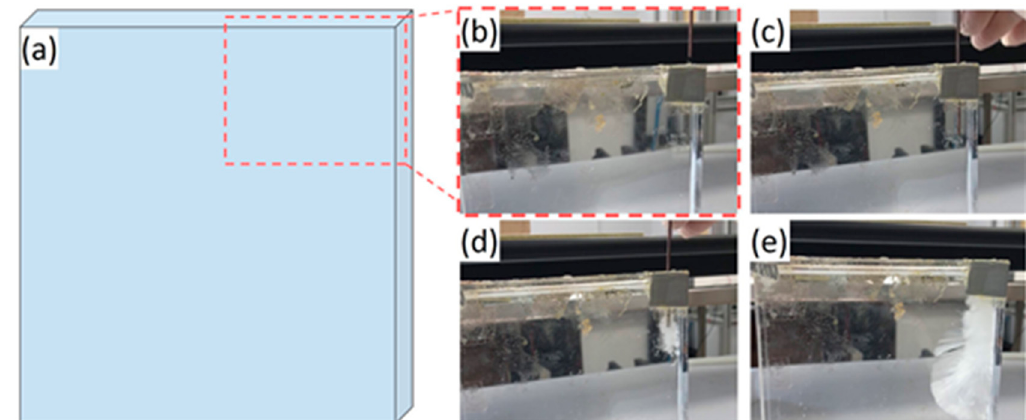
Figure 4. Seeding of sodium acetate trihydrate (SAT) with a welding rod. ( a ) Schematic draw of the brick and detailed pictures (after the brick was taken out of the experimental bench) ( b ) initial state; ( c ) insertion throughout the grey tape; ( d ) beginning of crystallization; and ( e ) growth of the crystal.